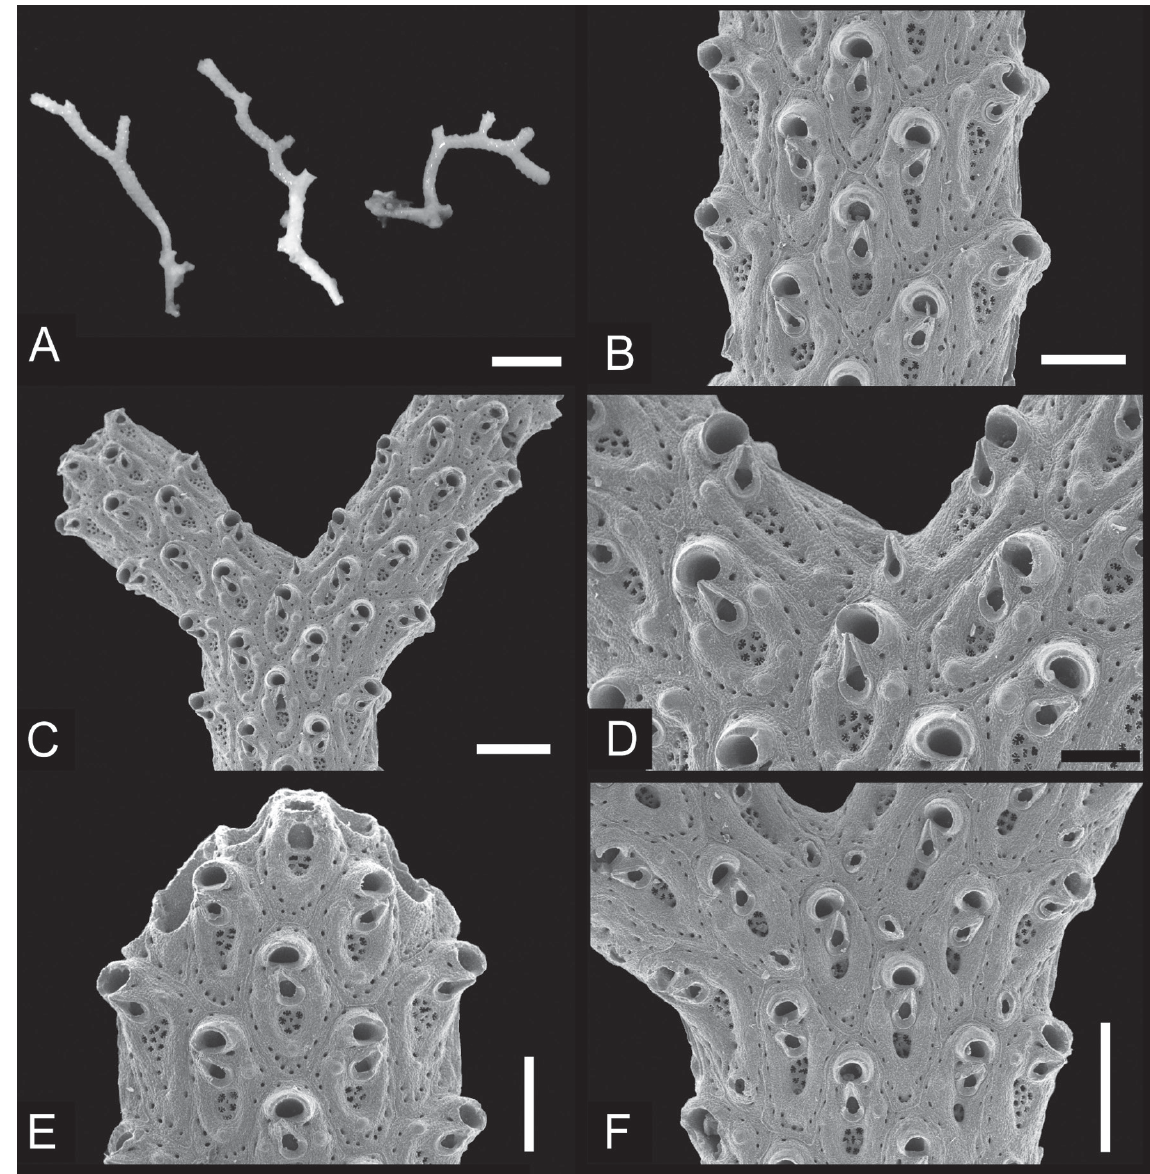
Fig. 16. Adeonellopsis toyoshioae sp. nov. A . Colonies from Amami oshima (NsMT-Te776). B . Branch showing autozooids with broad multiporous spiramen (NsMT-Te776). C . Branch showing crenulate periphery, with tubular peristomes and acute avicularia (NsMT-Te776). D . Branch bifurcation lacking vicarious avicularia (NsMT-Te776). E . Distal end of branch showing young autozooids with large multiporous spiramen (NsMT-Te776). F . old autozooids with immersed spiramen (NsMT-Te776). A = optical photograph; B–F = SEM images. Scale bars: A = 5 mm; B, E = 300 μm; C, F = 500 μm; D = 200